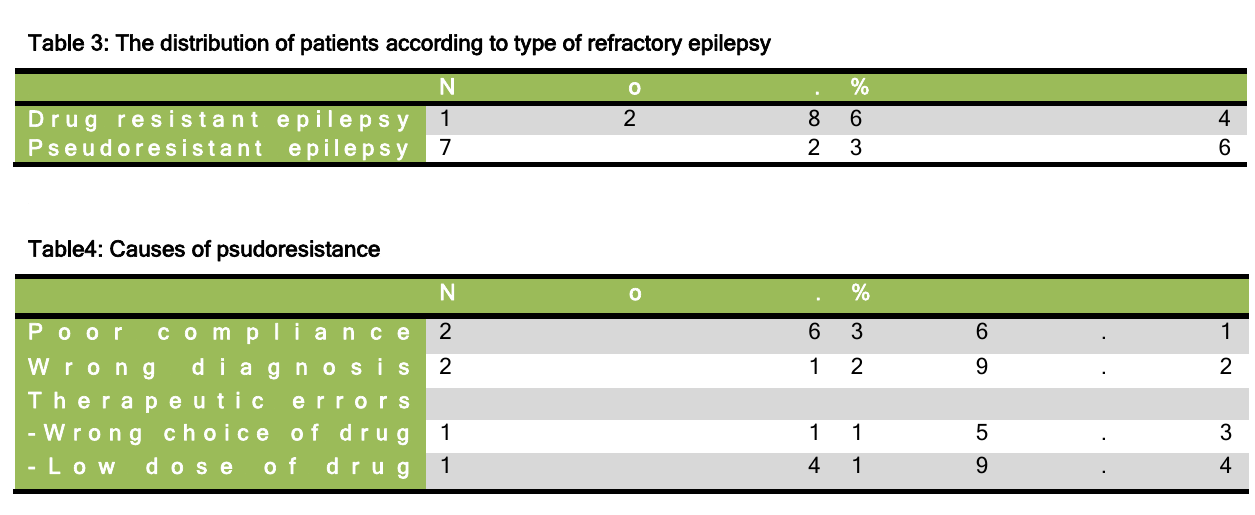
Table 3: The distribution of patients according to type of refractory epilepsy